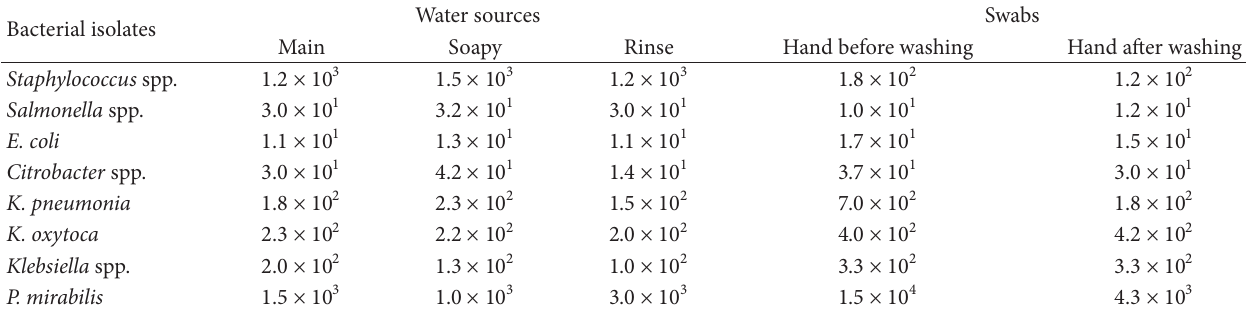
Table 3: Bacteria colony count of water samples (cfu/mL) and hand-swab samples (cfu/g). Water sources Swabs Bacterial isolates Main Soapy Rinse Hand before washing Hand after